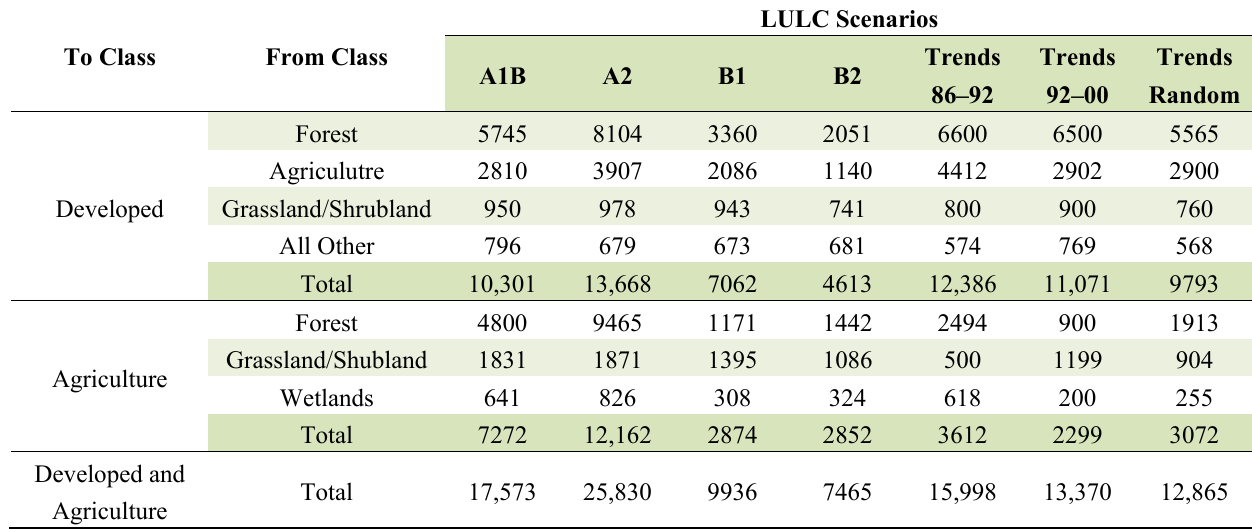
Table 3. Total projected Pacific Northwest land area conversions (km 2 ) between 2000 and 2100 to developed and agriculture for each